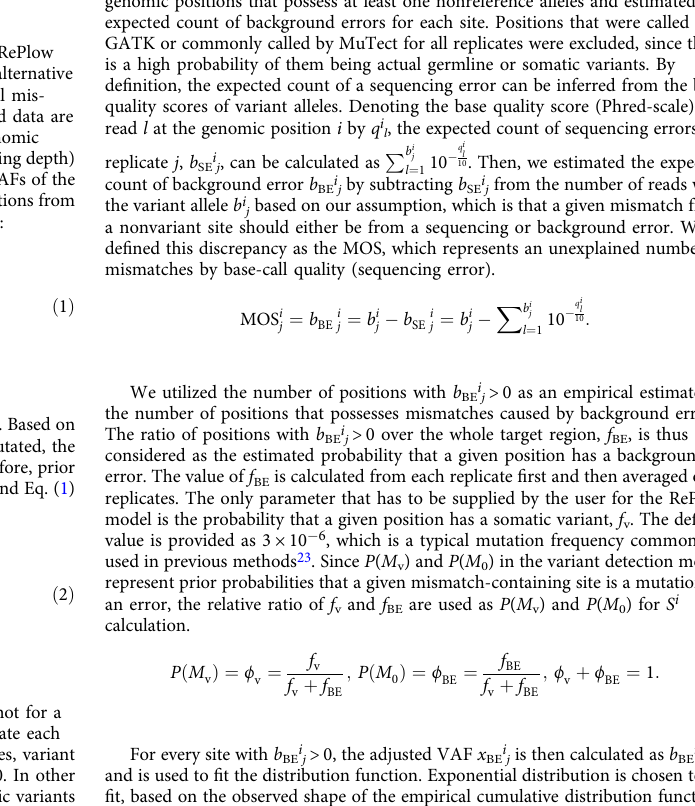
Table 1 and Supplementary Methods. Information for designed target regions per sequencing platform and platform-speci fi c answer sets are listed in Supple- mentary Datas 1 and 2.